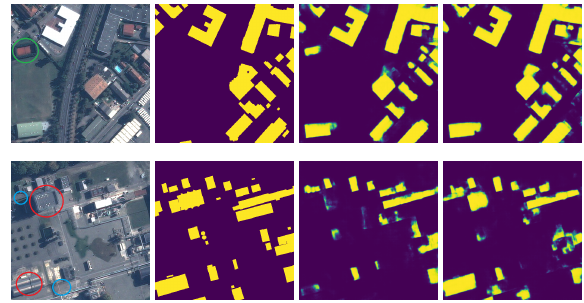
Figure 7. Advantage of stereo training for DispNetC network over other images of Toulouse (3, 4). From left to right : image, ground truth, monocular prediction and stereo prediction